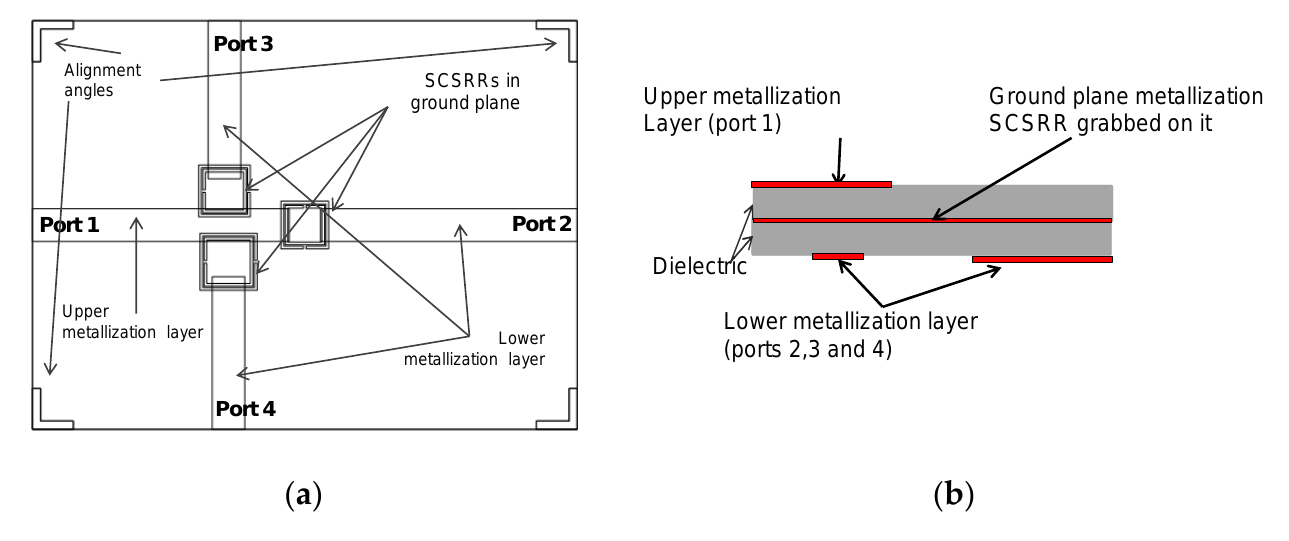
Figure 24. ( a ) Top view overlapped layer distribution of 2-layer triplexer SCSRR based. All output ports in upper layer are designed. ( b ) Front view layer distribution.